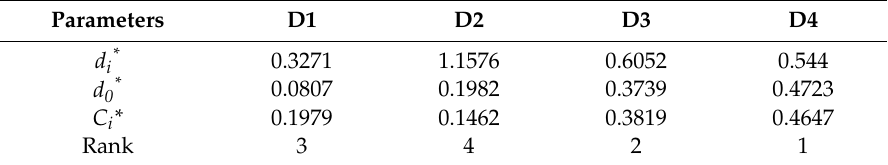
Table 9. Preference order of the evaluated